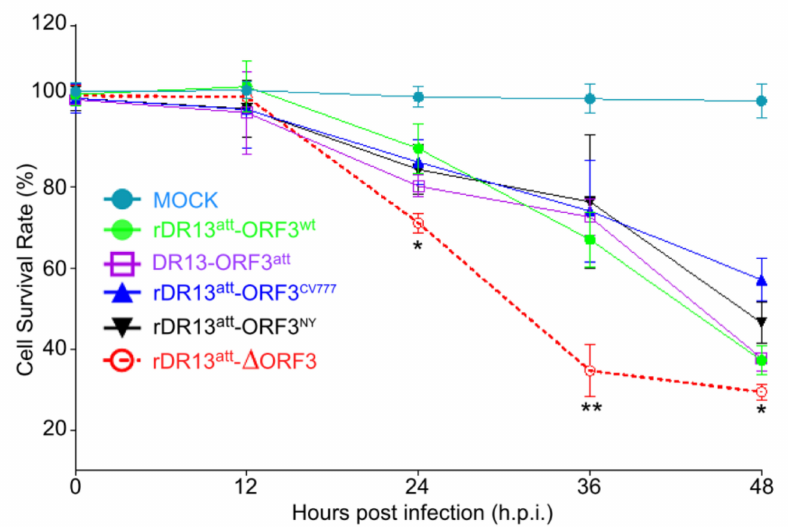
Figure 6. Cell viability after infection with rPEDVs and DR13 att . Vero cells were mock-infected or infected with rDR13 att -ORF3 wt , rDR13 att -ORF3 CV777 , rDR13 att -ORF3 NY , rDR13 att - ∆ ORF3, or DR13 att at a MOI of 0.1. Cell viability was determined at 12, 24, 36, and 48 h.p.i. and the viability of mock-infected cells was designated as 100%. Results are expressed as a percentage of control ± SD from at least three parallel tests. Symbols * and ** indicate that the di ff erence between the survival rates of cells infected by rDR13 att - ∆ ORF3 and other viruses is significant ( p < 0.05) or very significant ( p < 0.01),